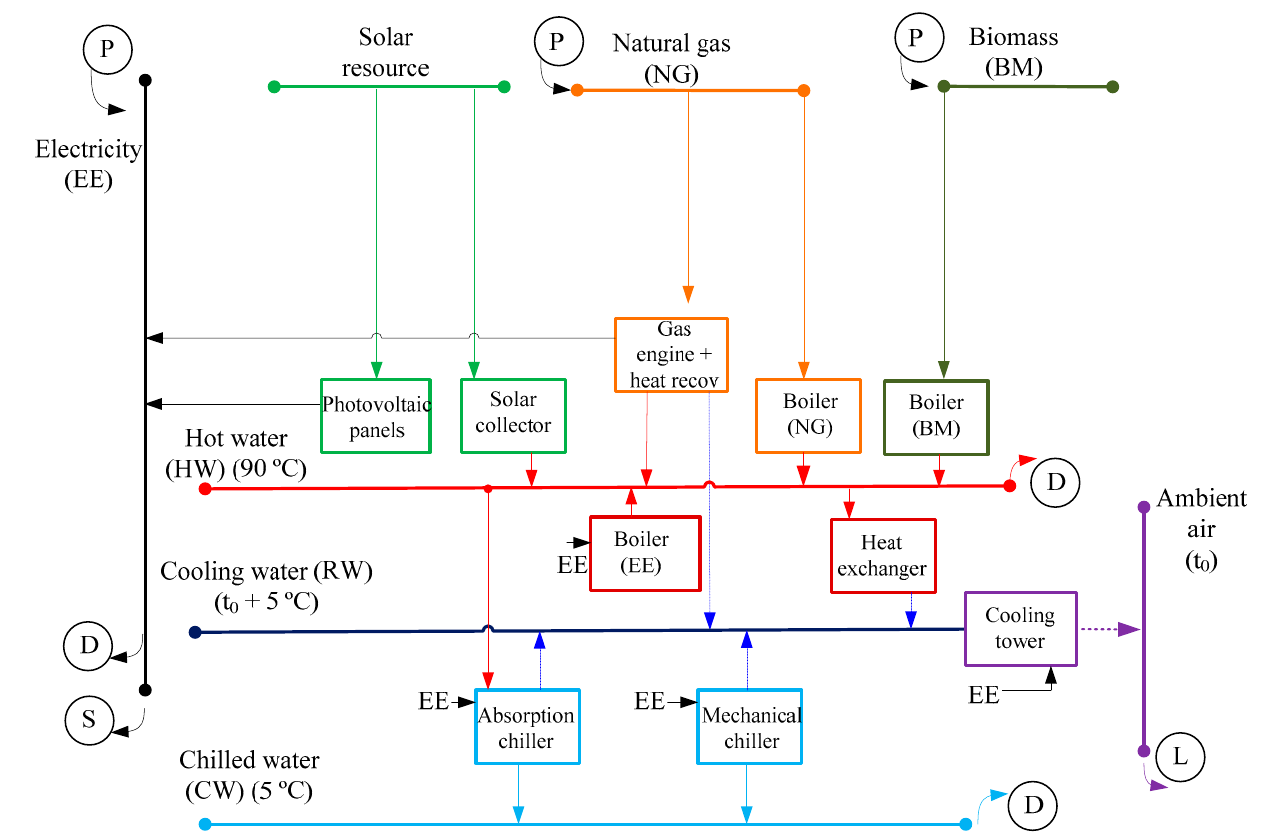
Figure 1. Superstructure of the energy supply system for the hotel.